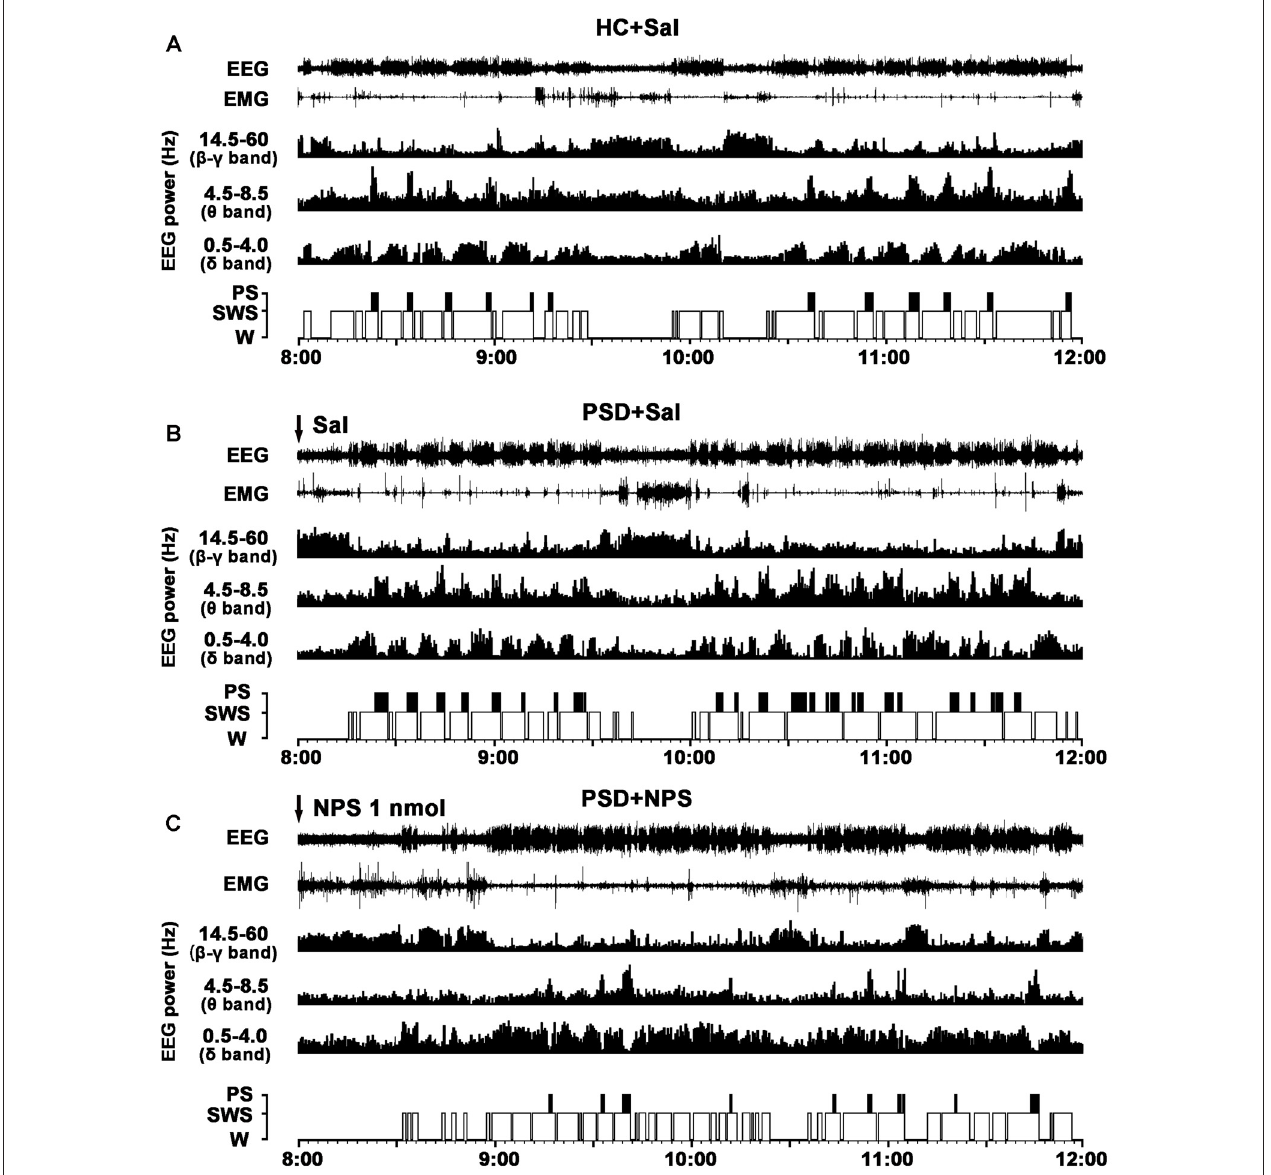
FIGURE 3 | Effects of NPS i.c.v. injection on the EEG and sleep-wake states after 24-h PSD. Representative 4-h (8:00–12:00) EEG, electromyogram (EMG), hypnograms, as well as cortical power spectra at 0.5–4, 4.5–8.5 and 14.5–60 Hz in HC + Sal (A) , PSD + Sal (B) and PSD + NPS (C) are shown. Note that the PSD + Sal rat had a long sleep latency characterized by fast and low-voltage activities in cortical EEG, as well as dense activity in EMG at the first hour, and subsequent marked paradoxical sleep (PS) and slow wave sleep (SWS) recovery as compared to HC + Sal rat. The PSD + NPS rat displayed an increase in wakefulness accompanied with increased cortical 14.5–60 Hz activities and suppressed cortical 4.5–8.5 and 0.5–4.0 Hz activities for about 30 min. After that, there was a SWS recovery accompanied with increased 0.5–4.0 Hz activities of cortical EEG.